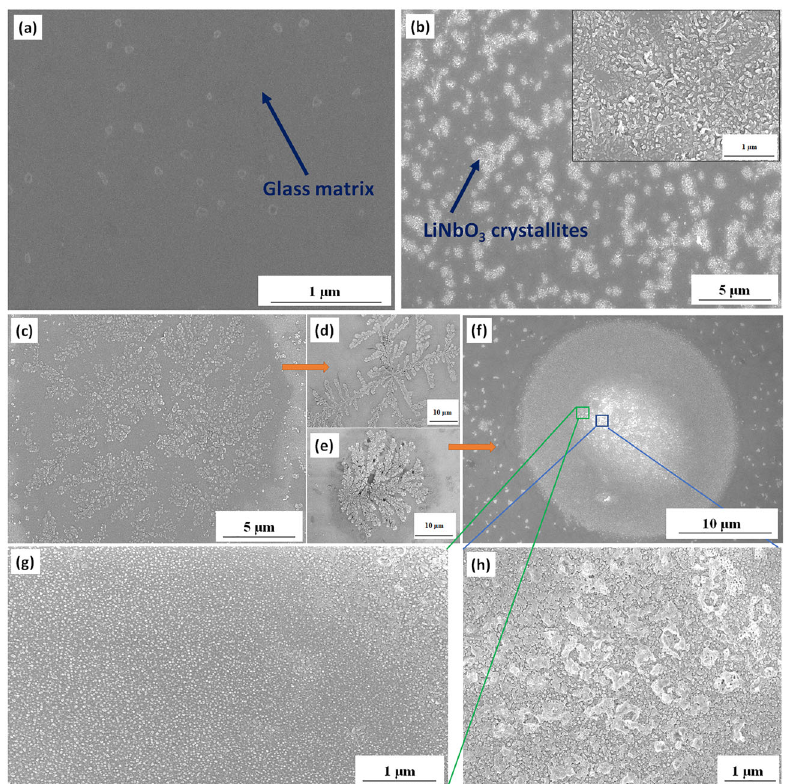
Fig. 2 Visualizing surface crystals. SEM micrographs obtained for a AQ-glass, b HT-2h, c , d HT-3h, and e – h HT-6h samples showing the presence of large number of LiNbO 3 crystallites on the surface of HT-2h, HT-3h, and HT-6h samples.